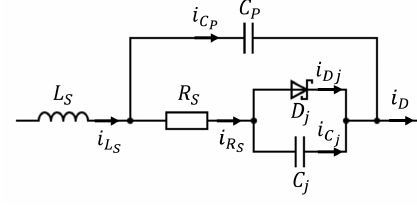
Figure 2. Diode equivalent circuit